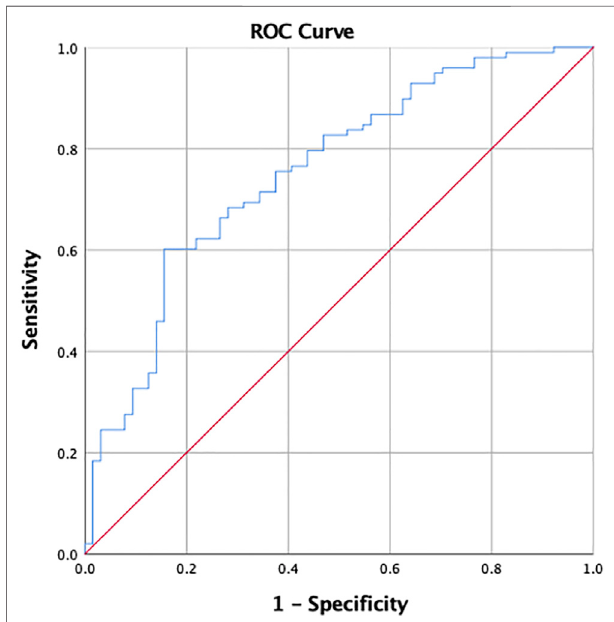
FIGURE 2 | ROC curve of model fi tting for active placebo effect prediction of goodness-of- fi t test.